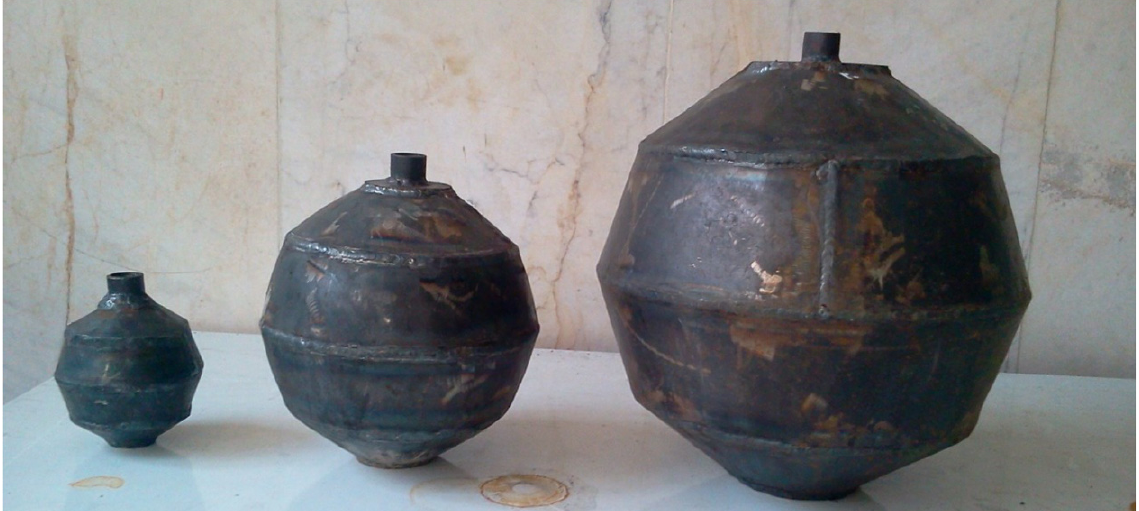
Figure 4. Test samples prior to explosion in three different diameters: D = 100, 200 and 300